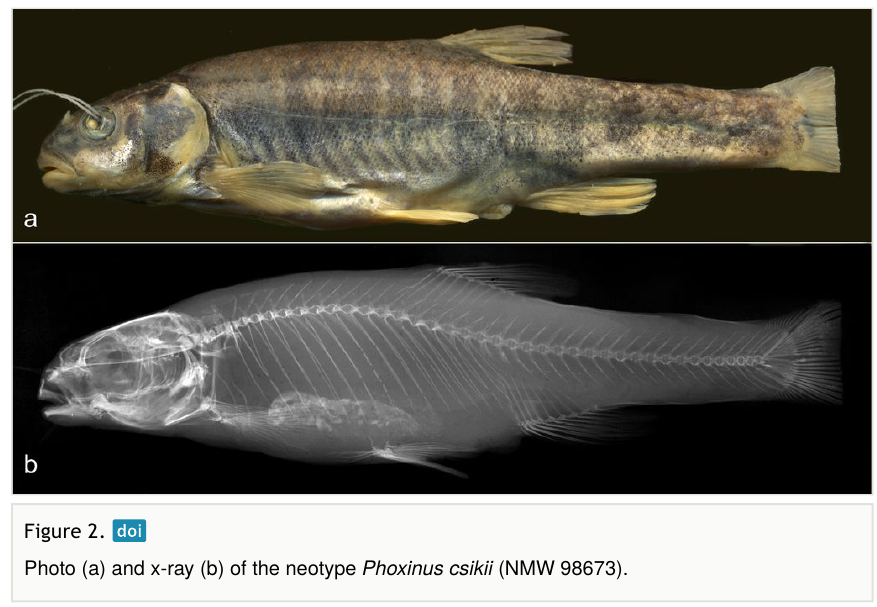
The neotype was collected close to the original type locality (Art. 75.3.6.) at Rožaje [Rozaj], Montenegro (42°50 ′ 39 ″ N, 20°10 ′ 00 ″ E), in the Ibar River, tributary to the Zapadna Morava river, a tributary of the Danube. The neotype is consistent with the original description (Art. 75.3.5) and can be unambiguously recognized (Art. 75.3.3.) through having the following characters: an incomplete lateral line almost continuous to the origin of the anal fi n with few single pored scales on the caudal peduncle (last pored scale in the middle of the caudal peduncle); 90 scales in the lateral series (51 pored, 39 non-pored); two patches of breast scales separated distinctly by a scaleless area; the posterior one-third of the area between the pectoral and pelvic origins scaled; eight branched rays in both the dorsal fi n and the anal fi n (the last two rays originating on a single pterygiophore); 16/15 branched pectoral fi n rays; 7/7 branched pelvic fi n rays; total vertebrae, 41 (22 abdominal and 19 caudal); depth of the caudal peduncle, 10.3% SL, 40.3% caudal peduncle length and 43% body depth; body depth, 24.8% SL.